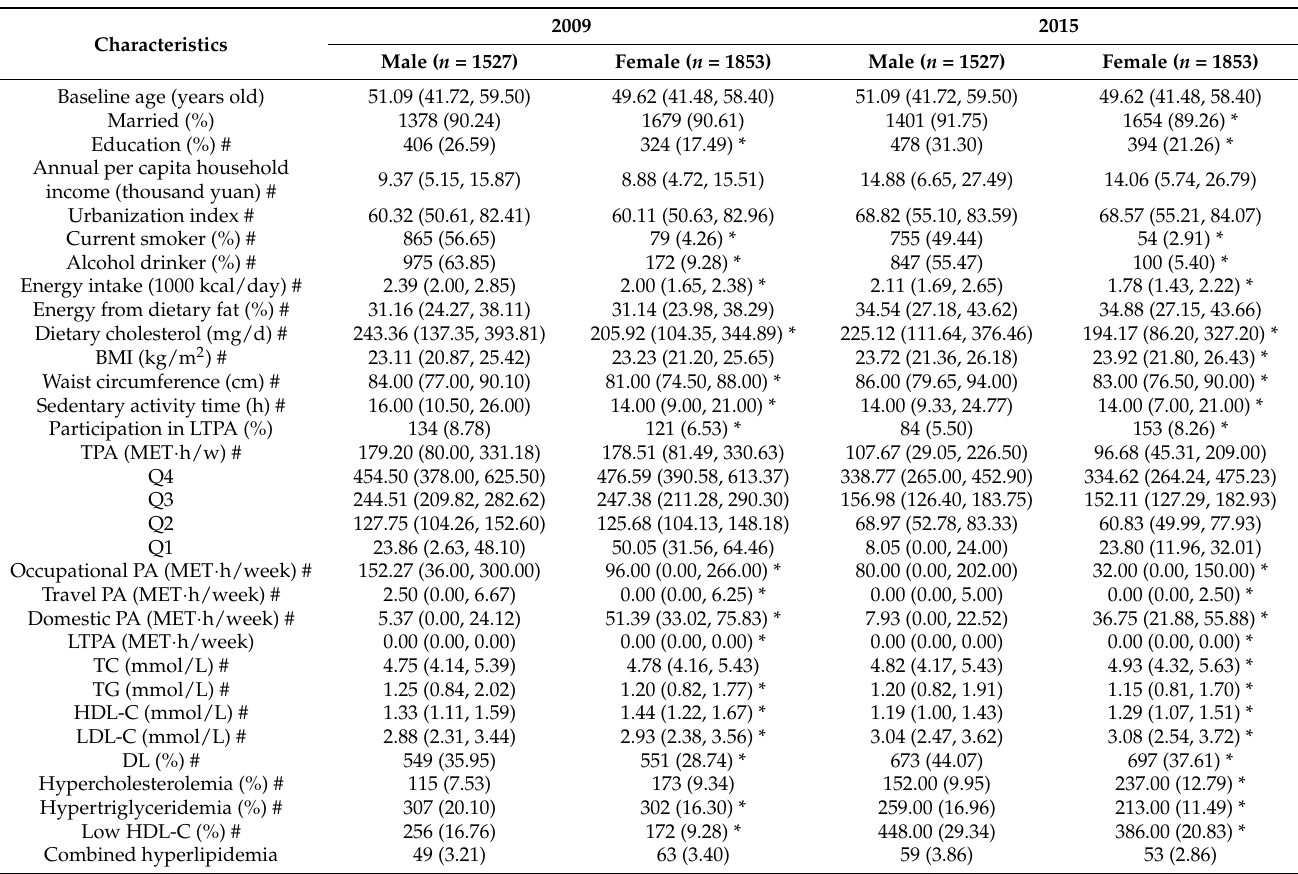
Table 1. Demographic characteristics of samples by gender from nine provinces of China in 2009 and